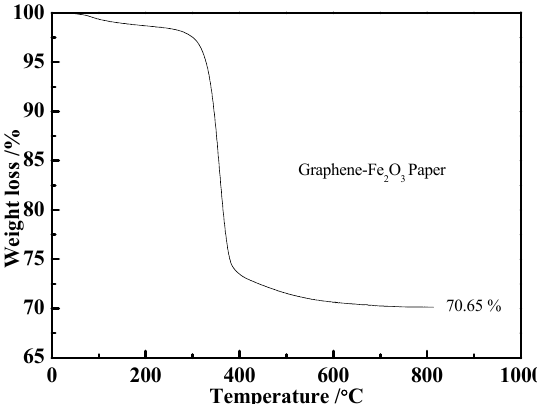
Figure 2. The XRD pattern of graphene-Fe 2 O 3 sheet. The weight ratio of Fe 2 O 3 nanoparticles in graphene-Fe 2 O 3 sheet is determined by thermogravimetric (TGA) measurements. Figure 3 shows the TGA curves of graphene-Fe 2 O 3 sheet. The TGA measurement identified the weight loss of TGA measurements from room temperature to 800 ◦ C. The 5% weightlessness of the samples below 250 ◦ C is primarily due to the removal of SDS and moisture on the surface of the graphene-Fe 2 O 3 sheet. There is a rapid weight loss evidently appearing at a temperature range of 250–400 ◦ C for the reason of the consumption of graphene and dehydration of oxides. After reaching 650 ◦ C, the loading of Fe 2 O 3 in the graphene-Fe 2 O 3 sheet resulting in 70.65% is stable with no further weight loss, indicating the triumphant synthesis of the sheet with a high mass loading of metal oxides [25].